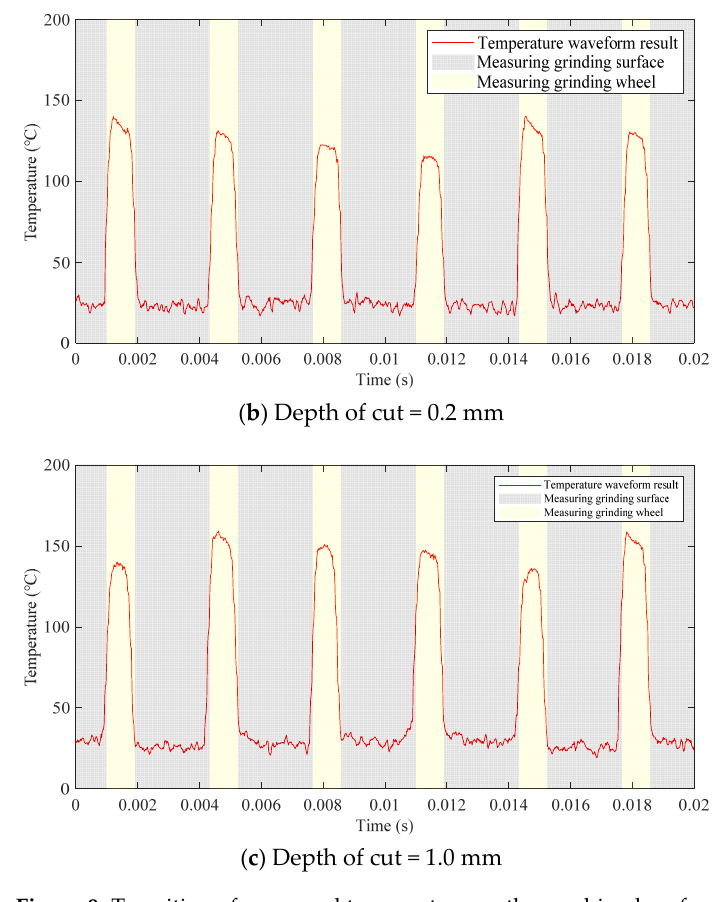
Figure 9. Transition of measured temperature on the machined surface and grinding wheel surface obtained from IR sensor, and the effect of depth of cut. (When measuring the temperature of the surface of the grinding wheel, 30 °C is 33–37 °C when converted to its emissivity.)